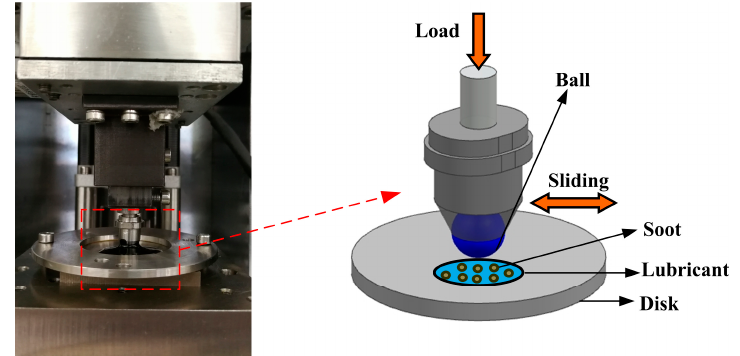
Figure 1. Configuration of the friction pairs of the ball-on-disk reciprocating tribometer.